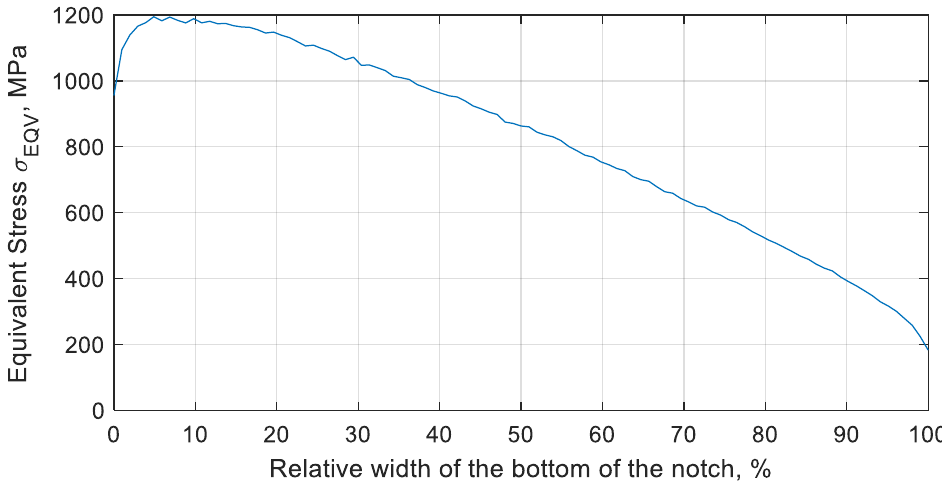
Figure 5. A plot of equivalent stress σ EQV (MPa) at the bottom of the notch, in the case of a resonance vibration with an amplitude equal to 1.8 mm.